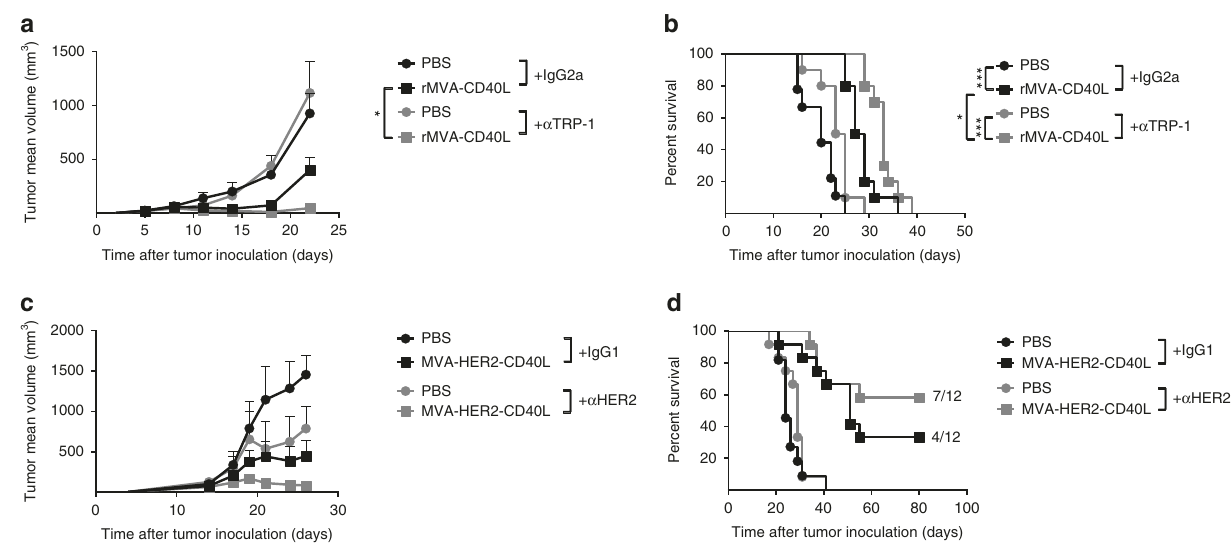
Fig. 5 Combination of MVA-CD40L and tumor-targeting antibodies enhances tumor growth control. a – d Enhanced tumor growth control when rMVA- CD40L immunization is combined with tumor-targeting antibodies. a , b B16.OVA tumor-bearing mice received PBS or were immunized with 5 × 10 7 TCID 50 of rMVA-CD40L (Day 0). Mice received 200 µ g of either IgG2a or anti-TRP-1 antibody i.p. at days − 2, 2, 6, and 10. a Tumor size follow-up ( n = 5